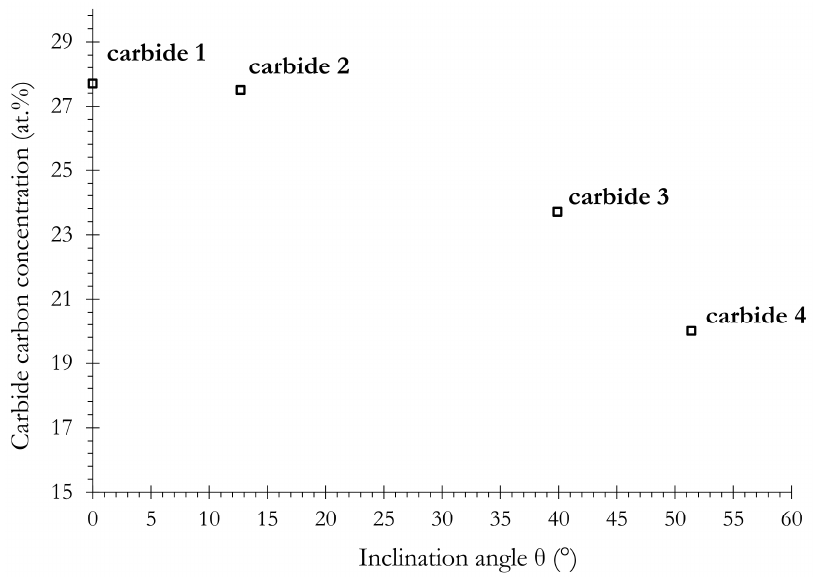
4 Figure 18. Impact of the inclination angle on the measurements of carbon concentration of